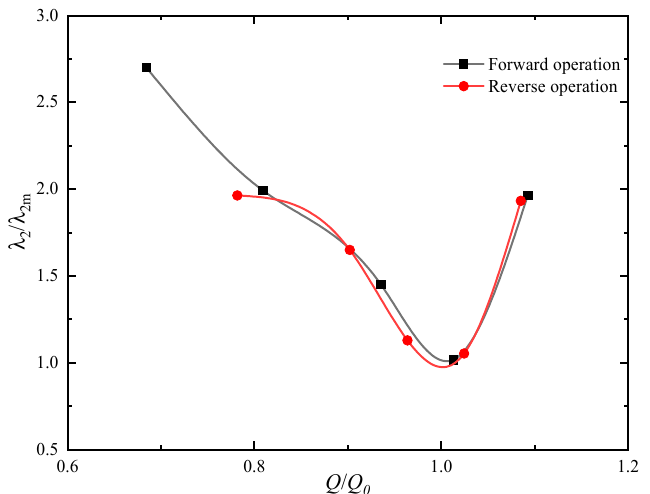
λ′ ′ / / ( λ for reverse) with 2 2 m m 2 2